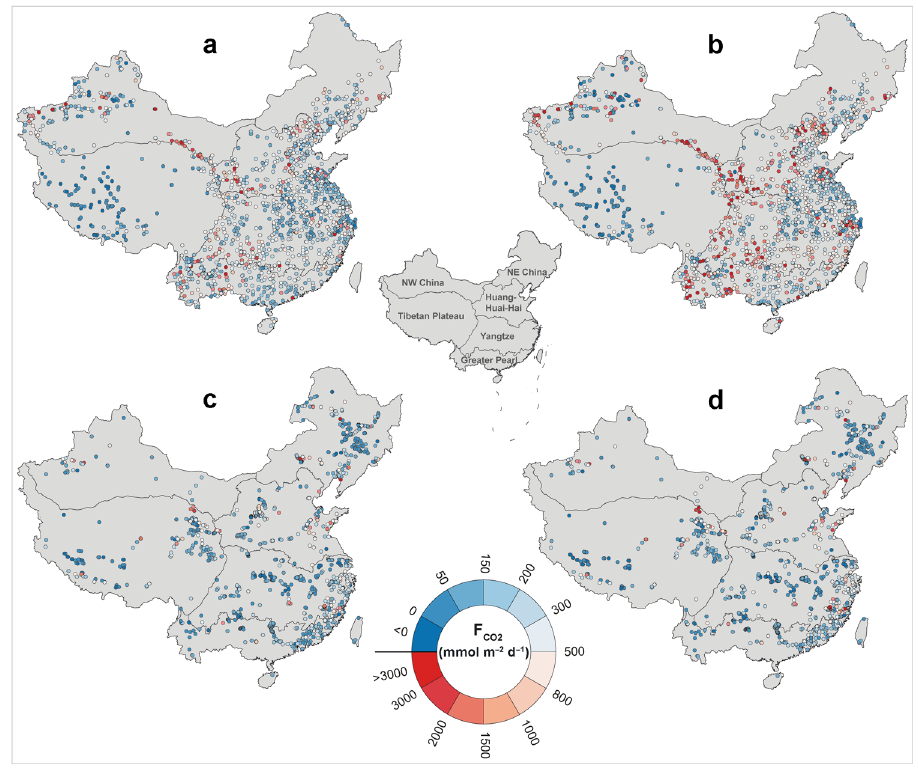
Fig. 1 Spatial variations in CO 2 ef fl ux from inland waters across China. Dry season ( a ) and wet season ( b ) in the 1980s, and dry season ( c ) and wet season ( d ) in the 2010s. The names correspond to the regions discussed in the text (Supplementary Section 1).